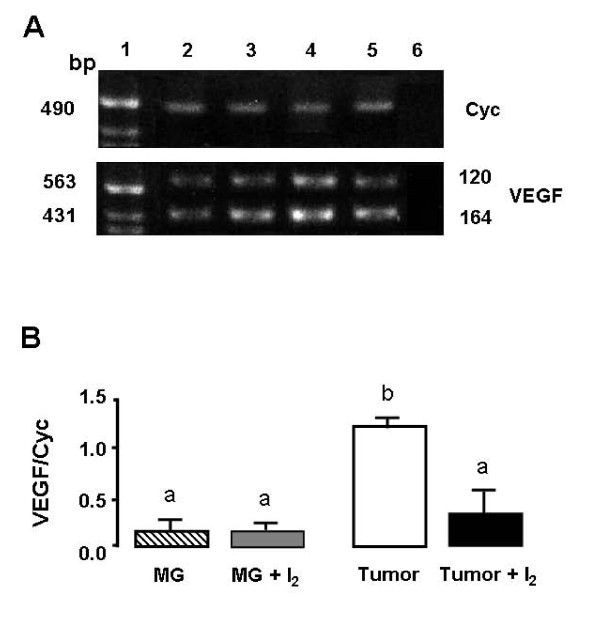
Vascular Endothelial Growth Factor (VEGF) expression. Isoforms of VEGF mRNA in normal (MG) or tumoral (tumor) mammary glands from control or I2-treated rats were measured by the real time PCR method. A. Representative gel of amplicon of Cyclophilin (Cyc) and 120 and 164 isoforms of VEGF mRNA in 2% agarose gel stained with ethidium bromide. 1, ladder; 2, MG; 3, MG + I2., 4, Tumor; 5, Tumor + I2; 6, all the PCR reagents without RT sample. B. VEGF mRNA quantification. Cyclophilin (Cyc) served as internal control and was used to normalize for differences in input RNA. Data are expressed as the mean ± SD. Differences between experimental groups were analyzed using a one-way ANOVA and the Tukey-HSD Test. Means with different letters are significantly different (p < 0.05)